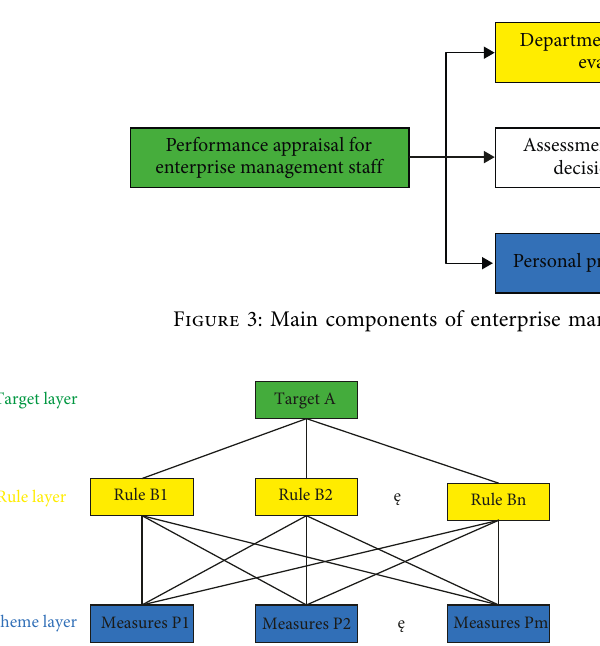
Figure 4: Main flow for enterprise strategic target